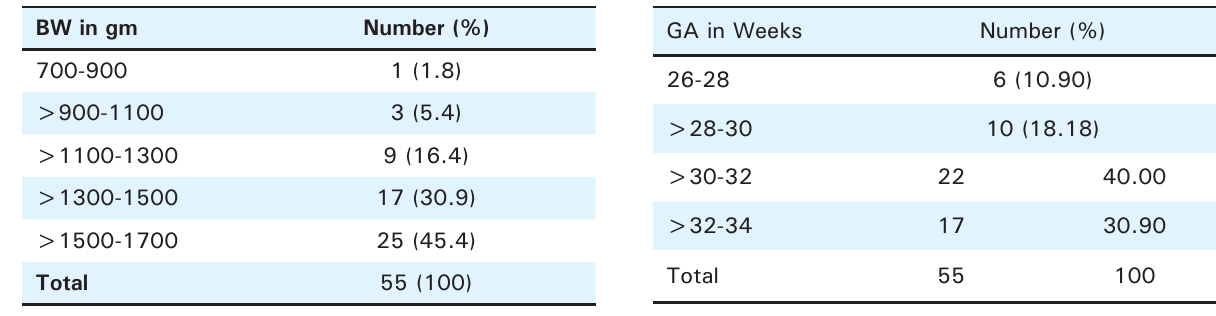
Table 2. Frequency and distribution of infants according to the gestational age